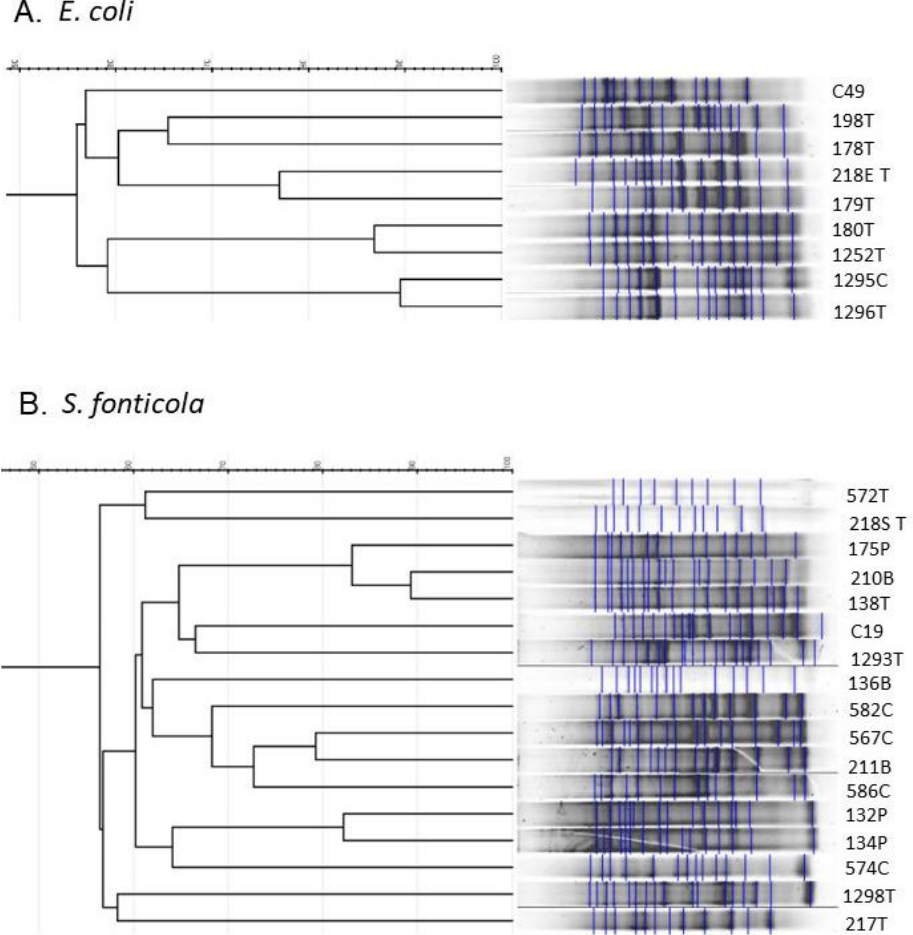
Figure 4. Fingerprinting profiles of E. coli ( A ) and S. fonticola ( B ) cephalosporin-resistant strains iso- lated from meat samples. The profiles were obtained with ERIC rep-PCR primers and analyzed with